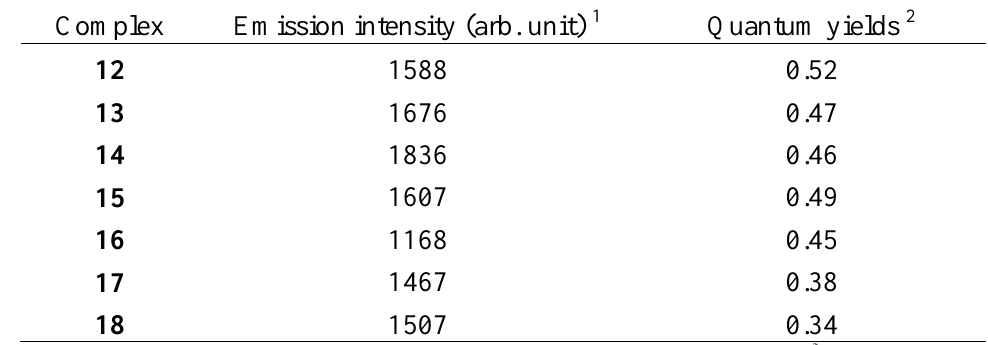
Table 3. The emission intensity and quantum yields of Eu(III) complexes with  -diketonates and non-symmetric bis-phosphine